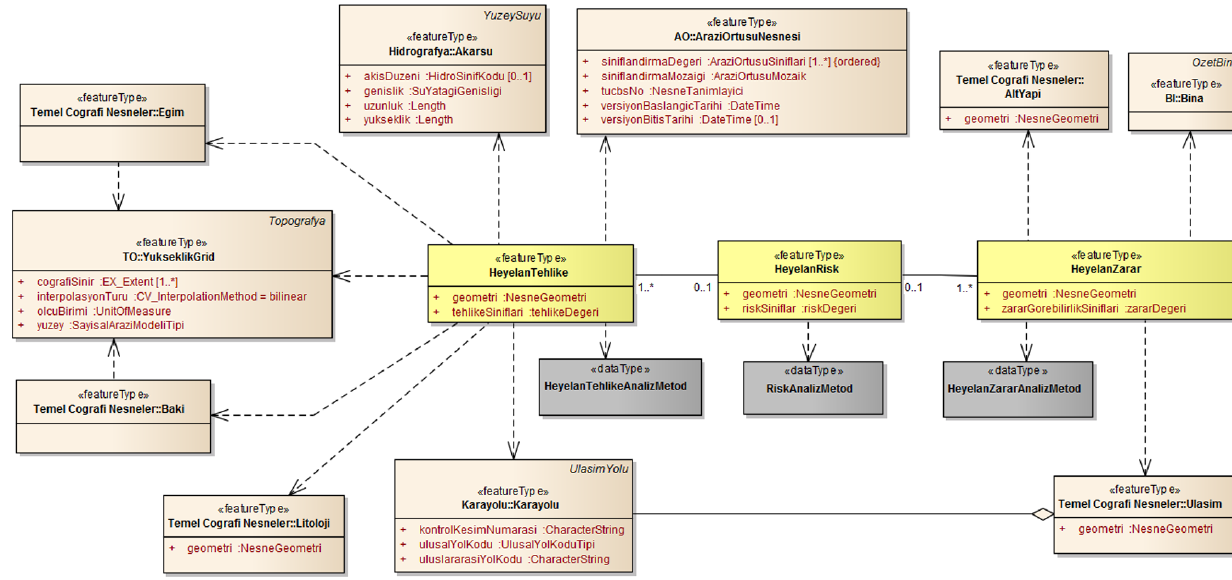
Figure 3. Relations between hazard, vulnerability and risk feature types.